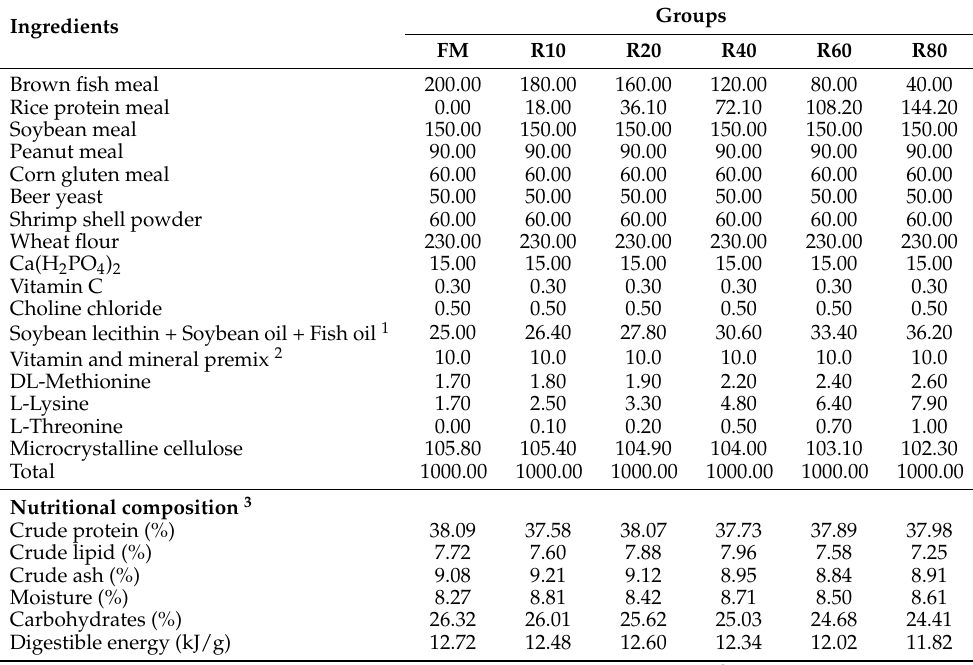
Table 1. Formula and nutritional composition of diets (g · kg − 1 ).